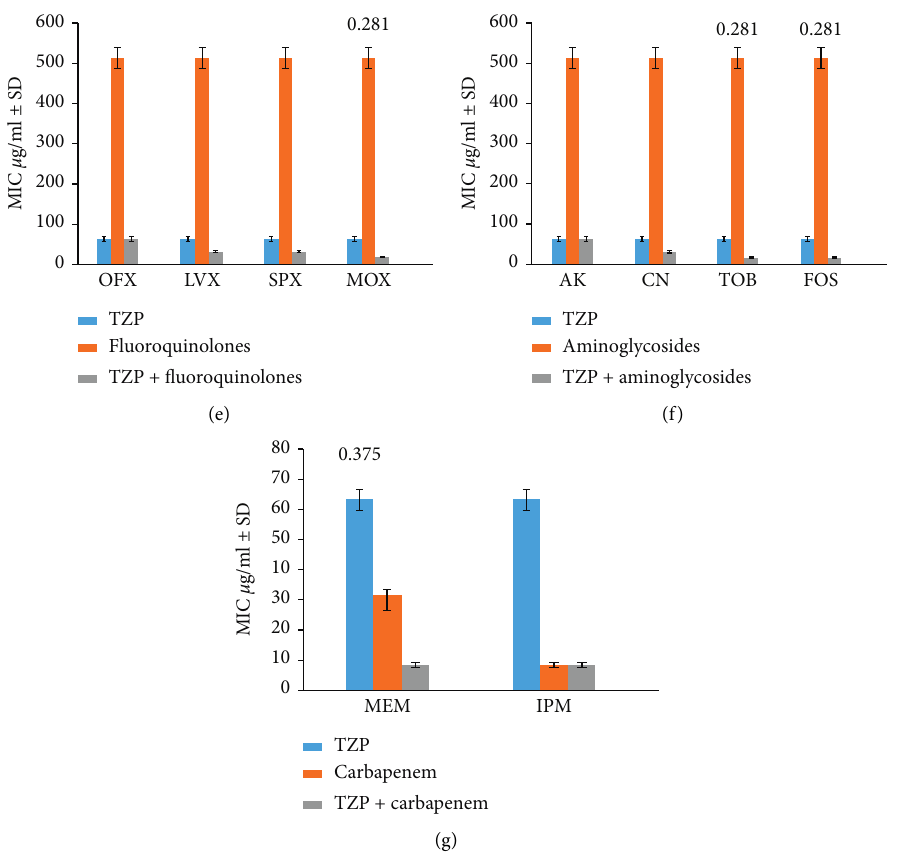
Figure 2: Triple antibiotic testing against MRSA. (a) List of triple combinations. (b) Amoxicillin-clavulanic acid-cephalosporin MIC indicates that synergistic relationship exists only between amoxicillin-clavulanic acid-cephradine (FICI 0.281). (c) MIC of amoxicillin- clavulanic acid-fluoroquinolone combination shows that synergy exists in all combinations (FICI 0.25 each). (d) A significant decrease in MIC of amoxicillin-clavulanic acid-aminoglycoside in combinations (FICI 0.125). (e) Reduction in combined MIC is only observed with moxifloxacin in piperacillin-tazobactam-fluoroquinolone combinations (FICI 0.281). (f) Significant activity is observed when piperacillin- tazobactam is combined with higher-generation aminoglycoside, i.e., tobramycin (FICI 0.281) and fosfomycin (FICI 0.281). (g) Meropenem in combination with piperacillin-tazobactam exhibits synergy (FICI